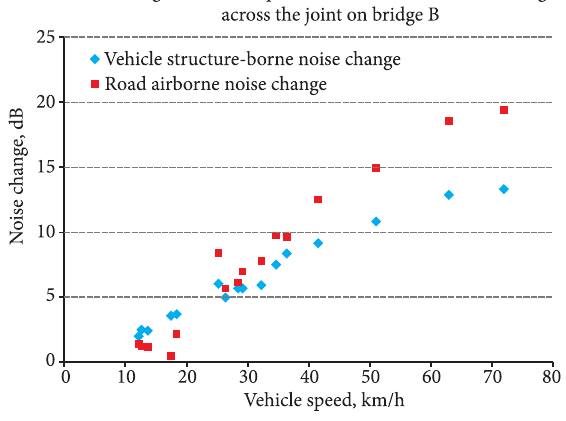
Fig. 13. The speed correlation of the measurement on Bridge B (using Acoustic-Box-in-Vehicle Methodology)